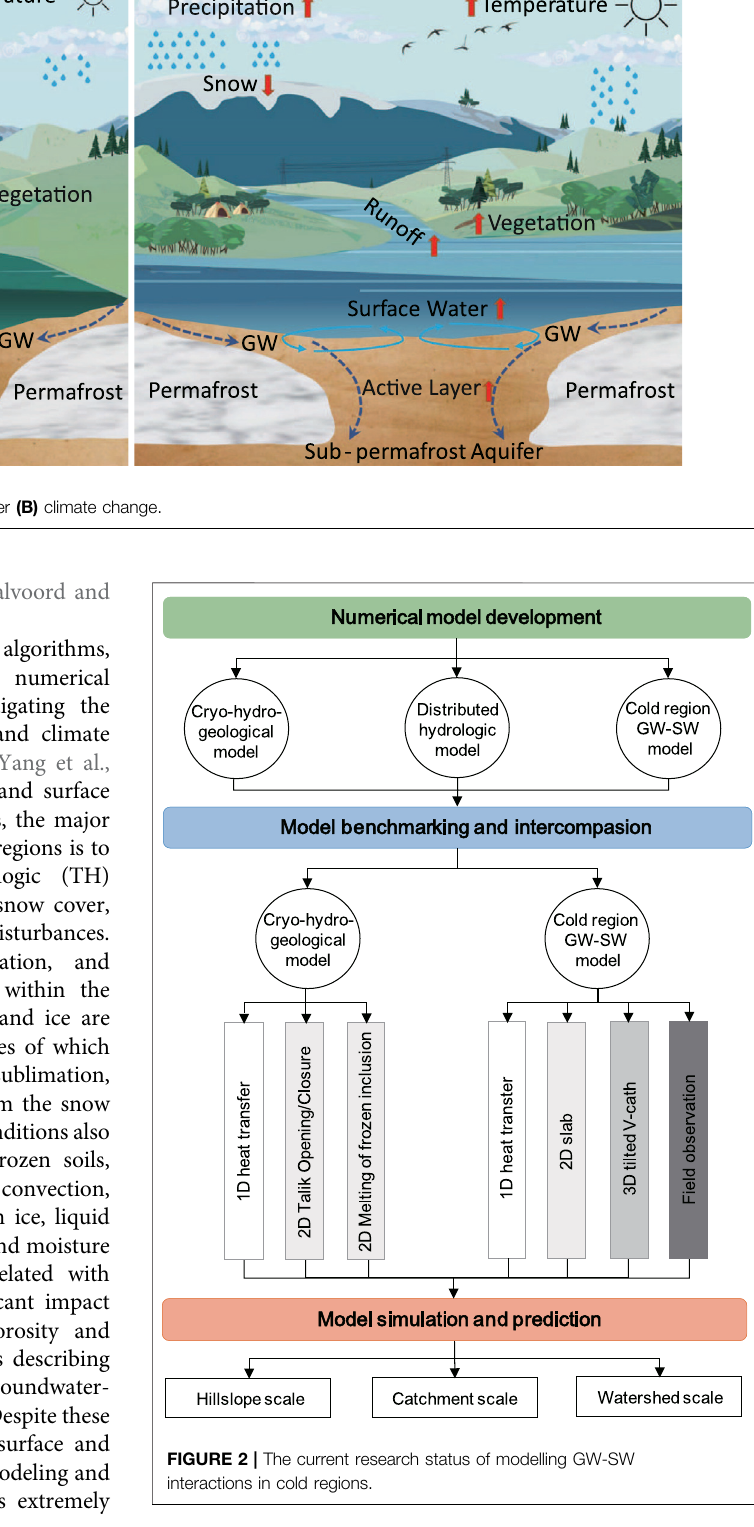
Frontiers in Earth Science |